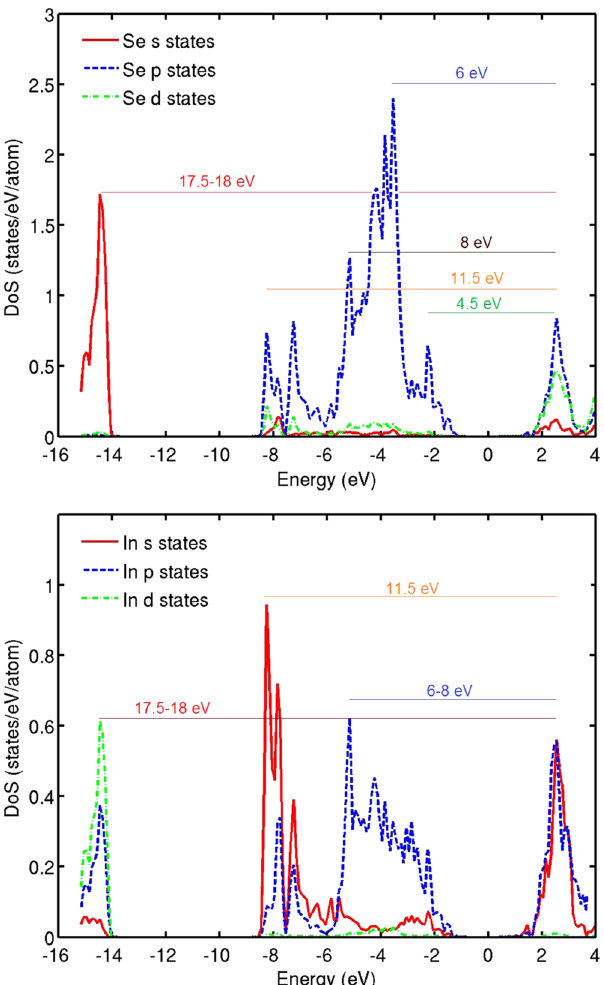
Figure 7. Single-particle transition energies, obtained from our EELS measurements, compared with theoretical DOS (calculated with HSE06) for Se- (top panel) and In-derived (bottom panel) states. Results obtained with the Perdew-Burke-Ernzerhof (PBE) functional are reported in the Supplementary